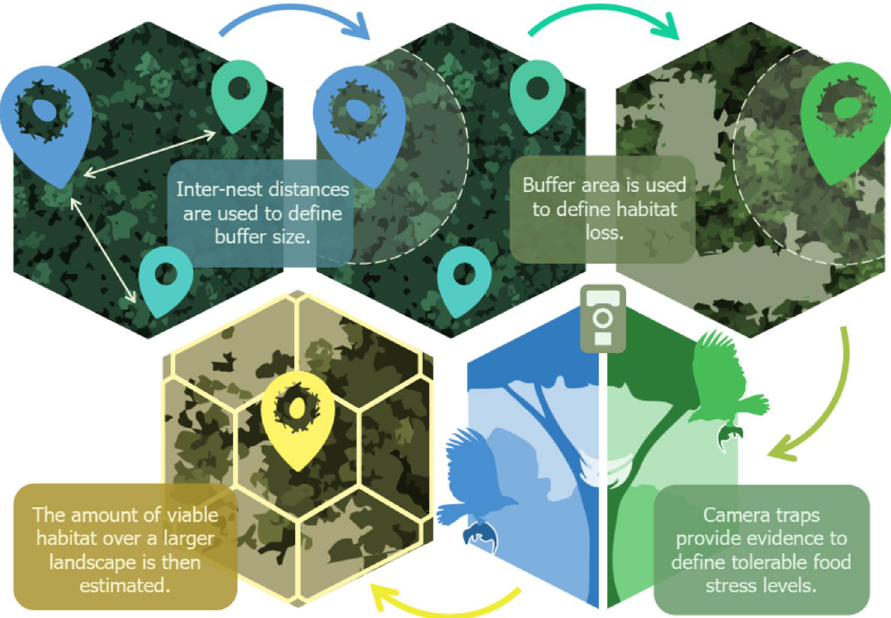
Figure 10. Clockwise flow chart summarizing the steps taken to estimate the effects of habitat loss on harpy eagle population viability. Inter-nest distances are used to define nest-centered landscape buffer sizes. Buffer area is used to obtain data on forest habitat loss. Camera traps provide evidence of tolerable food stress levels. Combining information on tolerable habitat loss and nesting territory size, we can scale up the habitat viability to much larger degraded landscapes (Author: Paula Viana, Corel Draw X8; https:// www. corel draw. com/